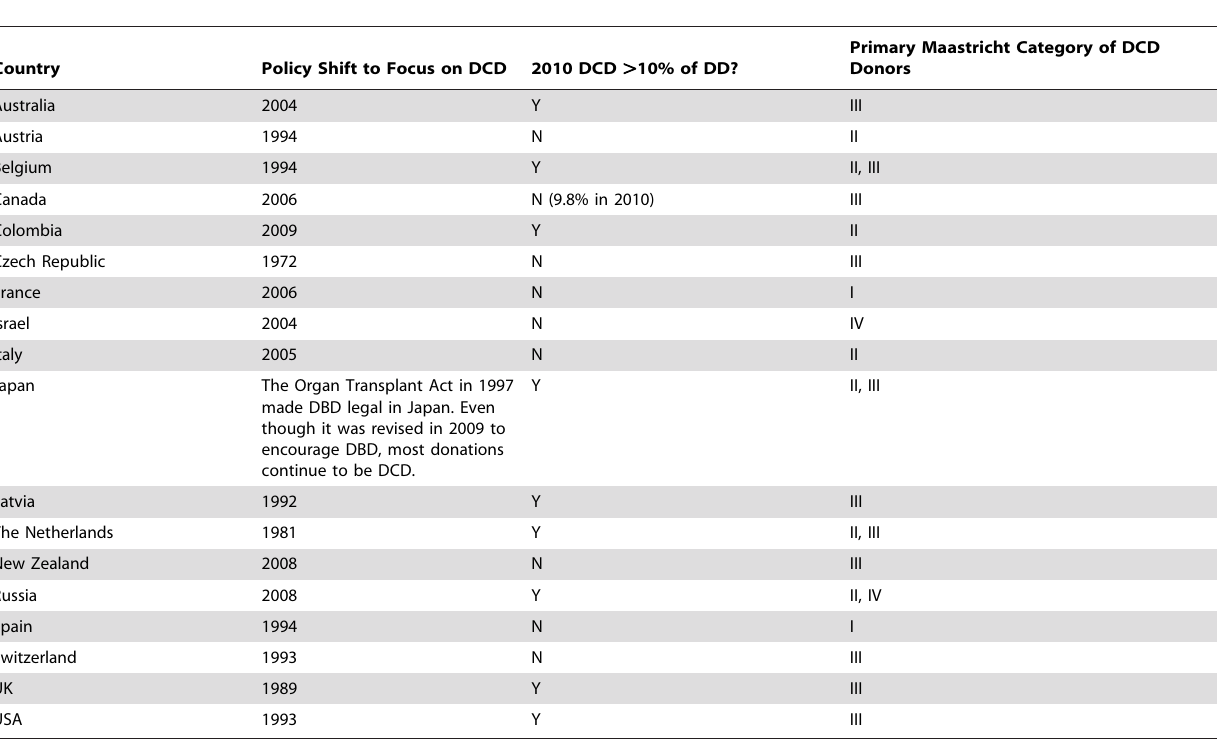
Table 1. Listing of Countries Utilizing DCD and Relevant Maastricht Categories (Adapted from Dominguez-Gil B, Haase-Kromwijk B, Van Leiden H, Neuberger J, Coene L, et al.) [18].